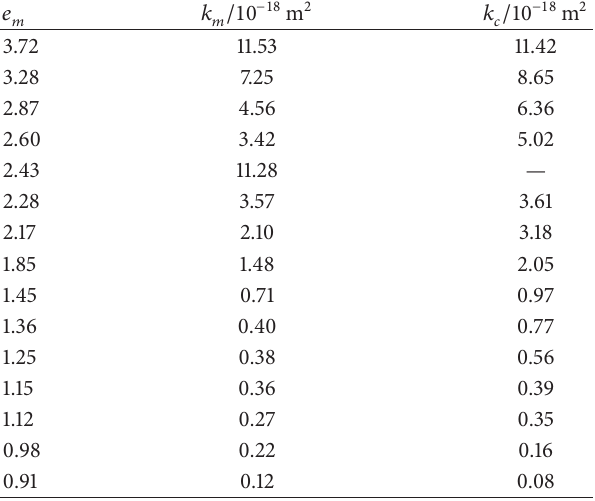
Table 4: Calculated and measured permeabilities of illite clay using the R-W